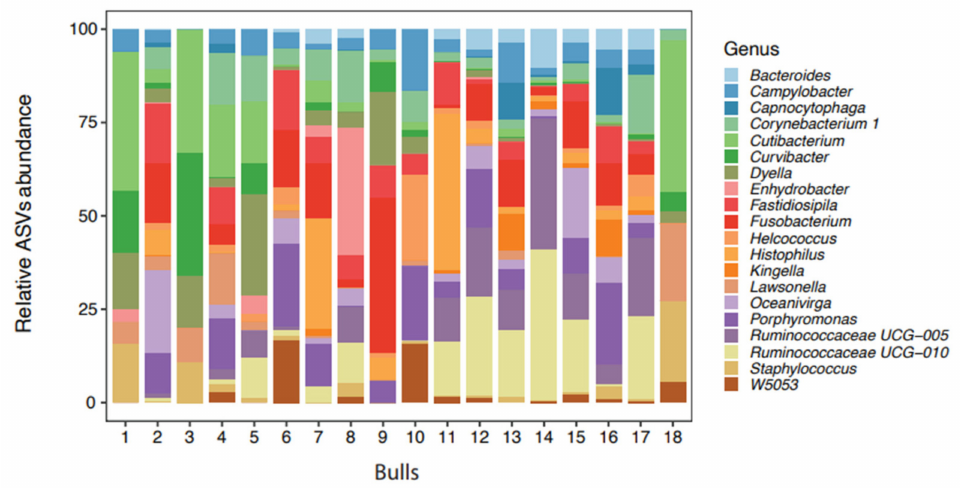
Figure 1. Distribution of the 20 most abundant bacteria genera in the semen from 18 bulls (amplicon sequence variants) identified by 16 rRNA